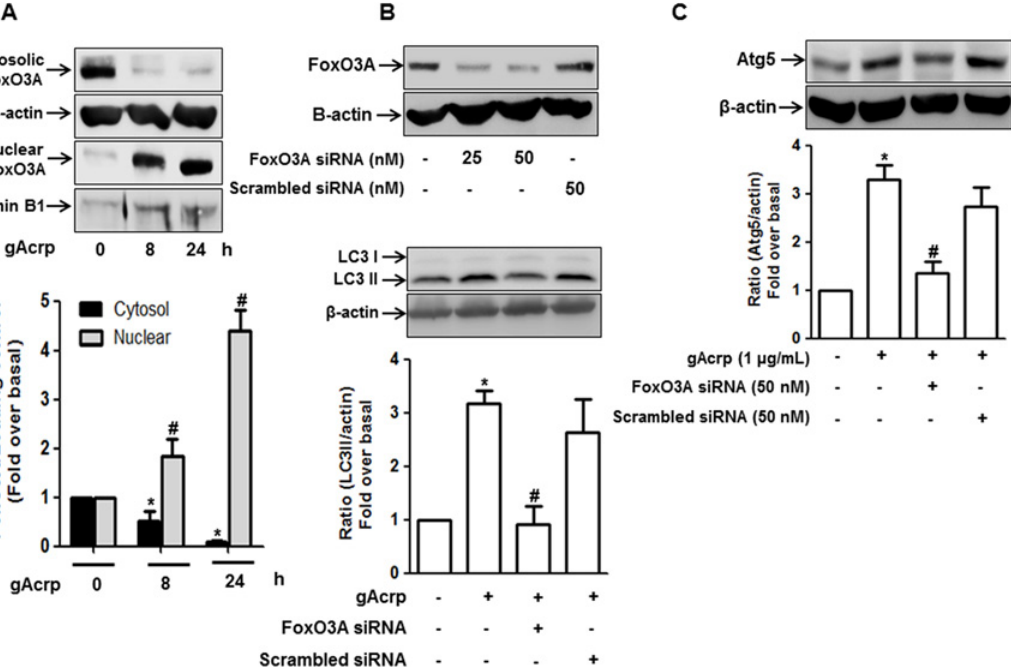
Fig 5. Role of FoxO3A signaling in the expression of autophagy-related genes by gAcrp in RAW 264.7 macrophages. (A) Cells were treated with gAcrp (1 μ g/ml) for the indicated time periods. Cytosolic and nuclear protein fractions were prepared as described in the materials and methods and the level of FoxO3A in each fraction was determined by Western blot analysis along with β -actin and lamin B1 as internal loading control for cytosolic and nuclear fractions, respectively. Quantitative analyses of foxO3A in cytosol and nucleus were performed by densitometric analysis and are shown in the graph (lower panel). Values are presented as mean ± S.E.M. * P < 0.05 compared with control cells in the cytosol fraction, # P < 0.05 compared with control cells in the nucleus fraction, respectively. (B) and (C) Cells were transfected with indicated concentration of FoxO3A siRNA or scrambled control siRNA for 48 h. The efficiency of FoxO3A silencing was measured by Western blot analysis, keeping β -actin as an internal loading control (Upper panel of figure B). Cells were transfected with siRNA targeting FoxO3A (50 nM) or scrambled control siRNA. After 48 h incubation, cells were treated with gAcrp (1 μ g/ml) for 24 h and LC3II (B) or Atg5 (C) protein expression levels were determined by Western blot analysis. Representative images from three independent experiments are shown keeping β -actin as an internal loading control. Quantitative analysis of LC3II and Atg5 expression were performed by densitometric analysis and are shown in the graph (lower panel of each figure). Values are presented as mean ± S.E.M. (n = 3). * P < 0.05 compared with control; # P < 0.05 compared to cells treated with